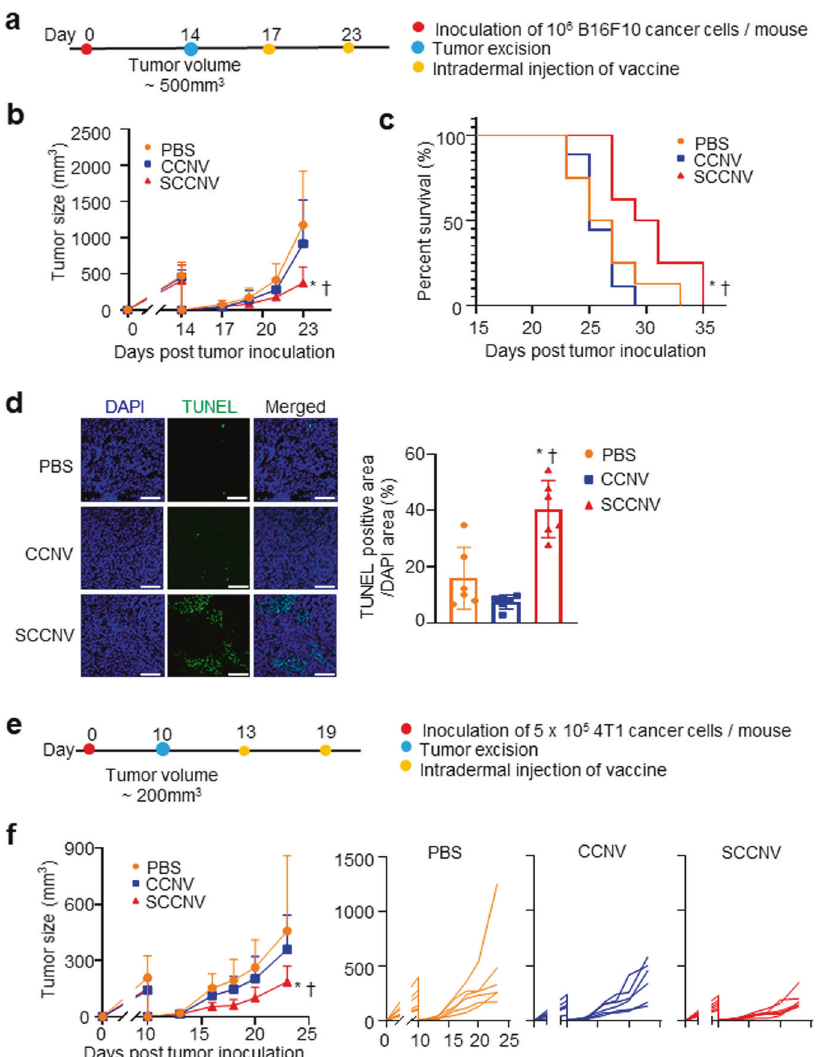
tissues harvested on Day 27. n = 6. Scale bars = 100 μ m. e Timeline of postsurgery recurrence in the 4T1 tumor model. f Tumor growth pro fi le. n = 6. Statistical signi fi cance was calculated by two-way ANOVA with Bonferroni posttests ( b and f ), the log-rank (Mantel – Cox) test ( c ), or one- way ANOVA with Tukey ’ s multiple comparisons test ( d ). * P < 0.05 versus PBS; † P < 0.05 versus